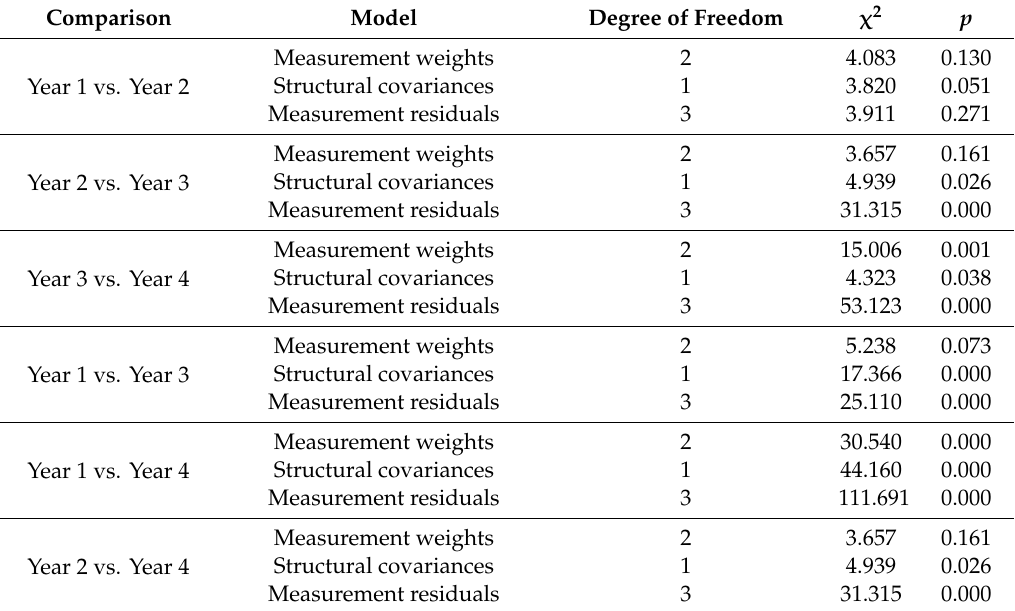
Table 5. Comparison of model results over the four academic